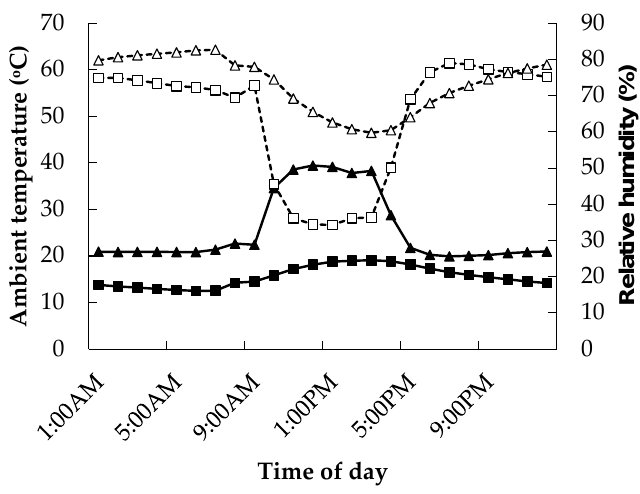
Figure 1. Ambient temperature ( ▲ , ■ ) and relative humidity (Δ, □ ) measured under constant thermoneutral temperatures (16–18 °C) ( ■ , □ , respectively) and under variable heated conditions (38 °C 9:00 AM–5:00 PM and 21–22 °C 5:00 PM–9:00 AM) ( ▲ , Δ, respectively).